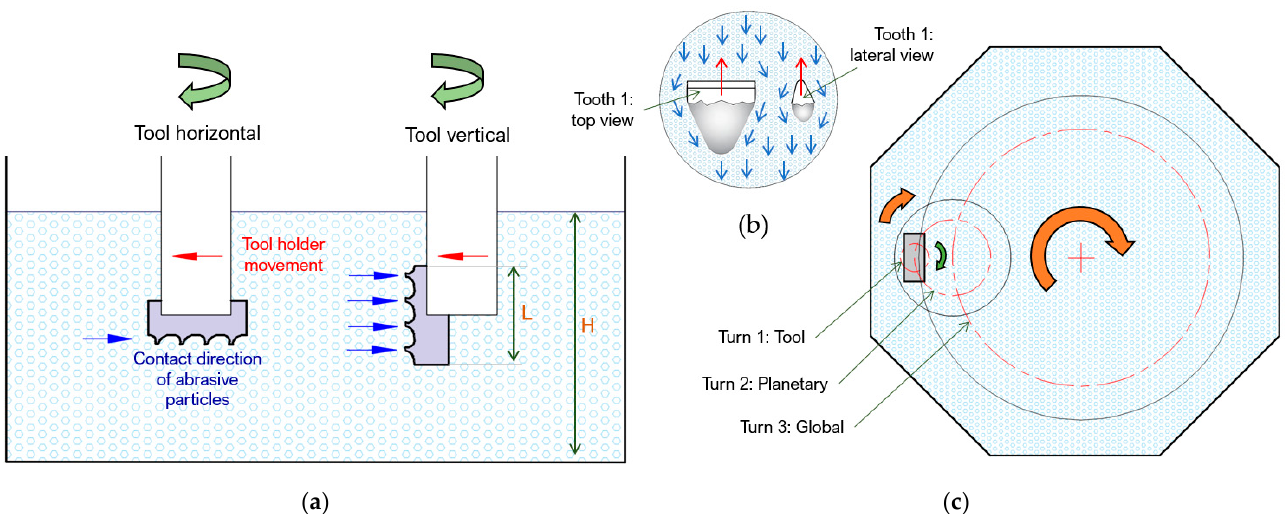
Figure 4. ( a ) The mounting of the broaching tool with different orientations, ( b ) the movement of abrasive particles against the first dragged tooth in horizontal orientation, and ( c ) relative movements of the tool in the drag finishing process.